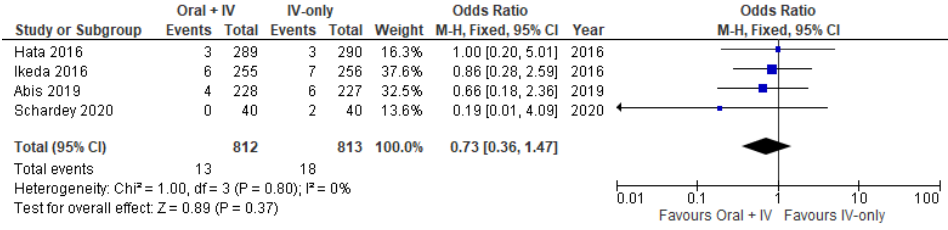
Figure 8. Forest plot of urinary tract disorder comparing oral + IV group and IV-only group.